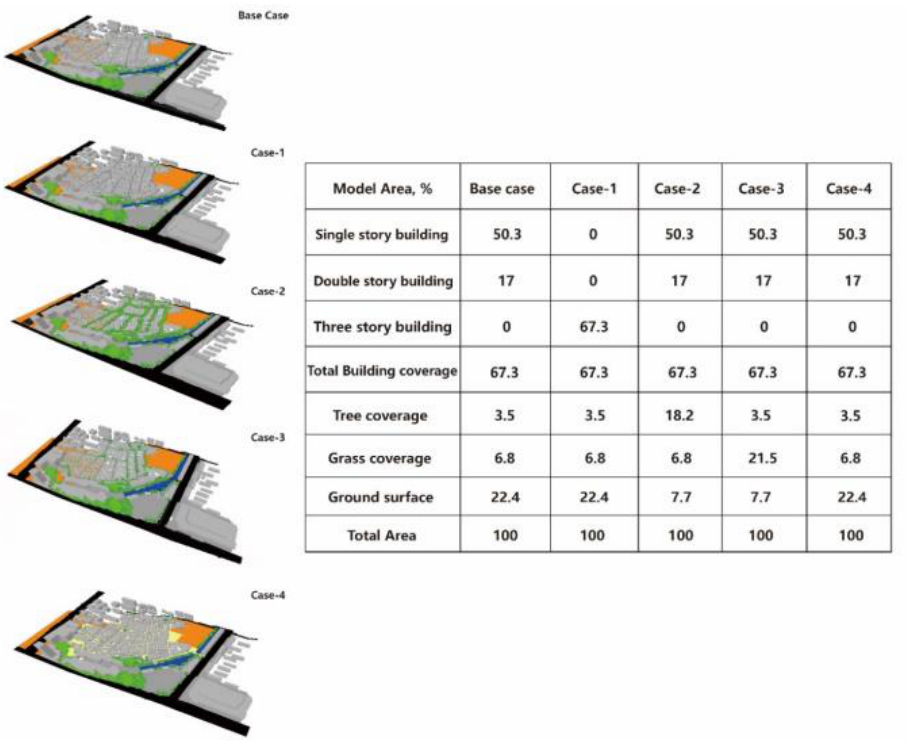
Table 7. The tested scenarios with new strategies.